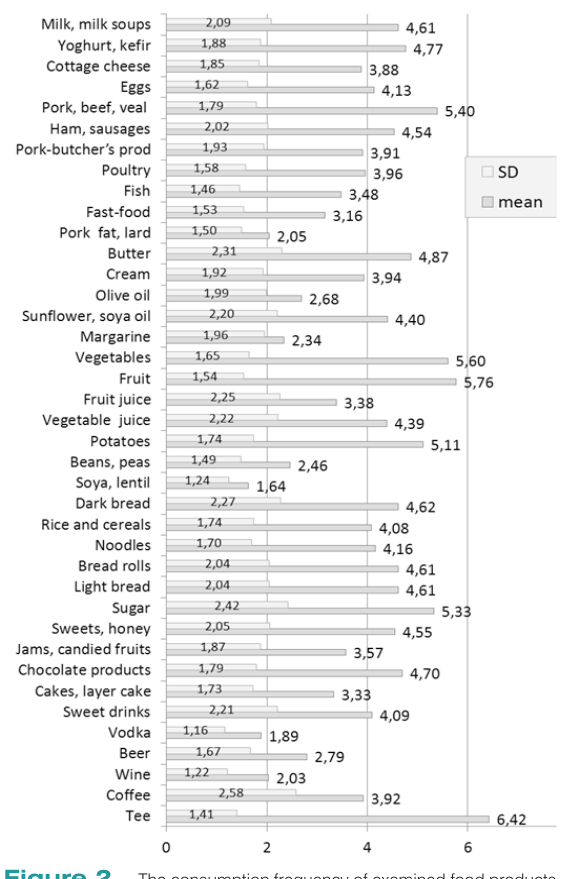
Figure 2. The consumption frequency of examined food products in all national groups studied (N=1517). Table 9. Linear multivariable regression model for percentage of fat depending on gender and frequency of consumed food. (R 2